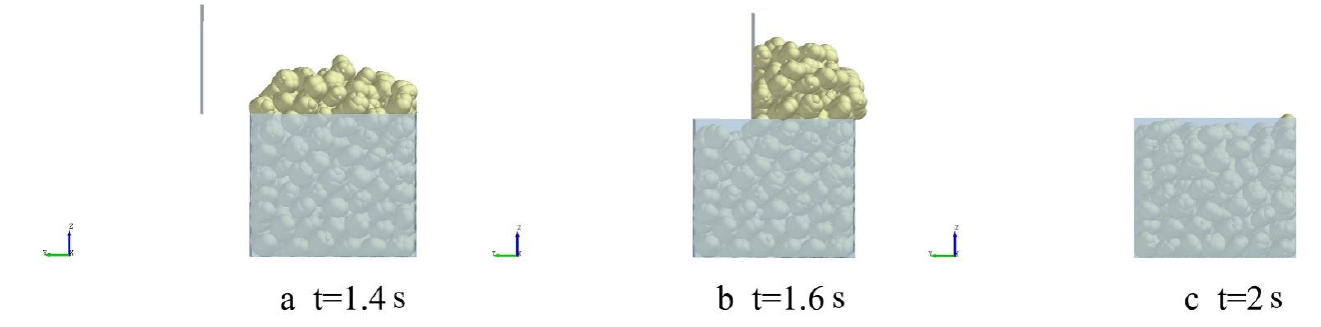
Figure 23. Snapshots of the simulation of the bulk density test of Jinong 3 seeds at different times using the 9-sphere model: ( a ) t = 1.4 s; ( b ) t = 1.6 s; ( c ) t = 2 s. using the 9-sphere model: ( a ) t = 1.4 s; ( b ) t = 1.6 s; ( c ) t = 2 s.